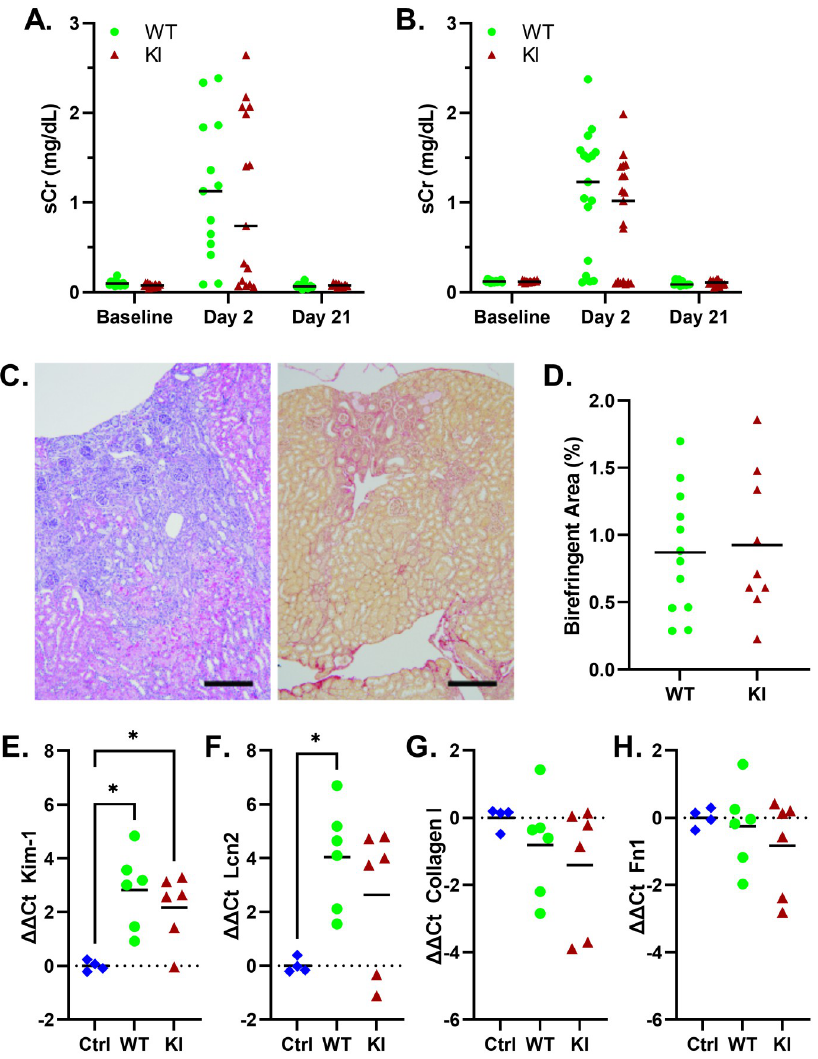
Fig 5. Trpc6 genotype does not influence response to folate nephropathy. Serum creatinine in WT and KI, male (A) and female (B), mice was elevated 2 days after folate administration, and recovered to baseline levels after 3 weeks. Shown are median and individual values; n = 13-19/group. There were no statistically significant differences between genotypes at any of the time-points; two-way ANOVA with Sidak’s multiple comparisons test. C, renal histology at day 21, demonstrating areas of tubular atrophy and interstitial fibrosis surrounded by relatively preserved cortical architecture. Shown are H&E stain of a male wild-type kidney section (left), and Sirius Red stain of a female KI kidney section (right); scale bar equals 100 μ m. D, the percentage of Sirius Red stained renal cortex area demonstrating birefringence 21 days after folate-induced AKI was compared between wild-type (n = 12) and KI (n = 9) male mice. Shown are mean and individual values; no differences between groups by unpaired t-test. The relative mRNA expression levels of renal injury related genes, Kim-1 (E) and Ngal/Lcn2 (F), and fibrosis genes, collagen I (G) and fibronectin (H), were compared between male control (Ctrl), and WT and KI folate-nephropathy kidney samples (n = 4-6/group). Shown are mean and individual values; Brown-Forsythe one-way ANOVA with Dunnett’s multiple comparisons. Only statistically significant pairwise comparisons are